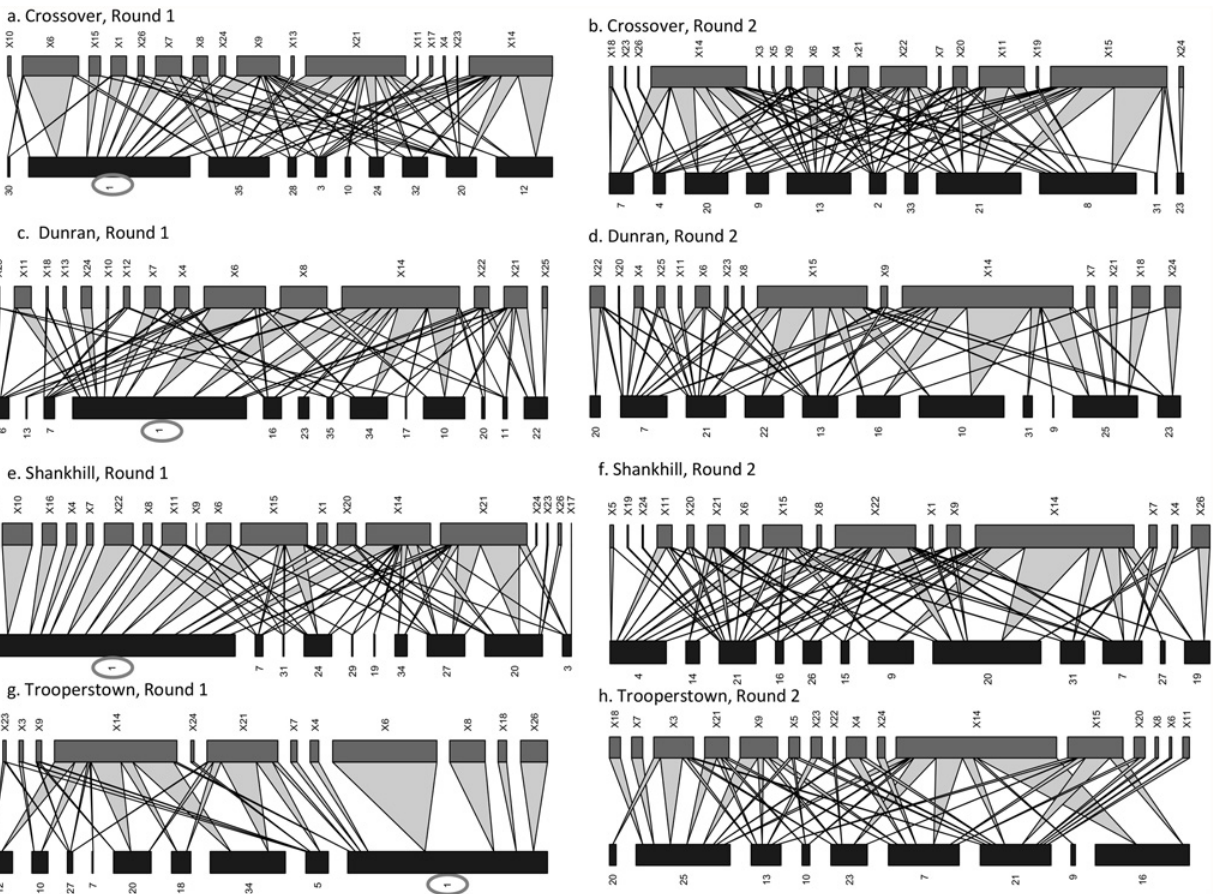
Fig 5. Quantitative insect-flower interaction networks Networks represent insect-flower communities at four Irish woodland sites during (a, c, e, g) and after (b, d, f, h) R . ponticum flowering. For each web, upper bar widths represent pollinator guild abundance while lower bar widths are determined by the interaction strength with insect species. On the lower bars, the number 1 corresponds to R . ponticum and is circled in gray; remaining species codes and pollinator guild abbreviations are listed in S1 & S2 Tables. Linkage width indicates the frequency of the interaction. One network was calculated for each site during each round of